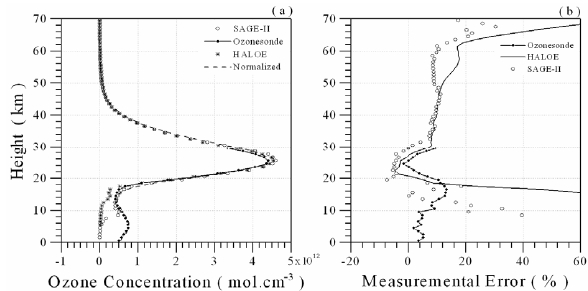
Fig. 3. (a) Height profile of overall mean ozone concentration obtained from Ozonesonde, SAGE-II and HALOE. The figure is superimposed with a normalized ozone concentration obtained from Ozonesonde and SAGE-II. (b) Height profile of relative percentage of bias in the ozone concentrations measured by Ozonesonde, SAGE-II and HALOE with respect to the normalized ozone profile. The percentage of bias is the ratio between the difference in ozone values and the normalized ozone profile.